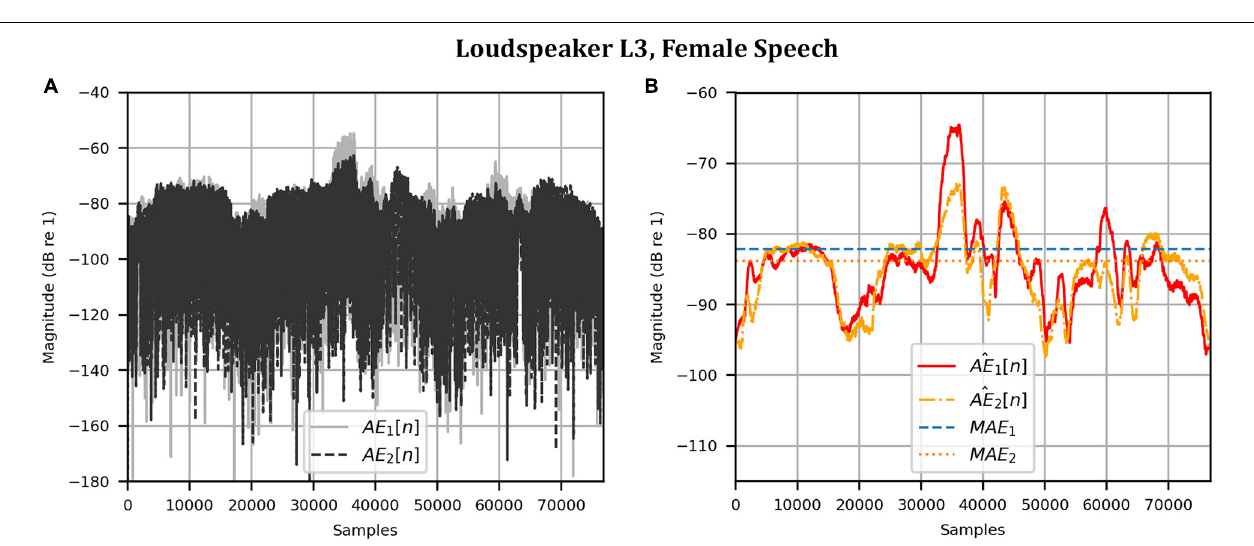
FIGURE 8 | Anechoic chamber: Error metrics quantifying the difference between the target and reproduced time domain waveforms in Figure 7 : (A) Unsmoothed absolute errors; (B) Smoothed absolute errors and mean absolute